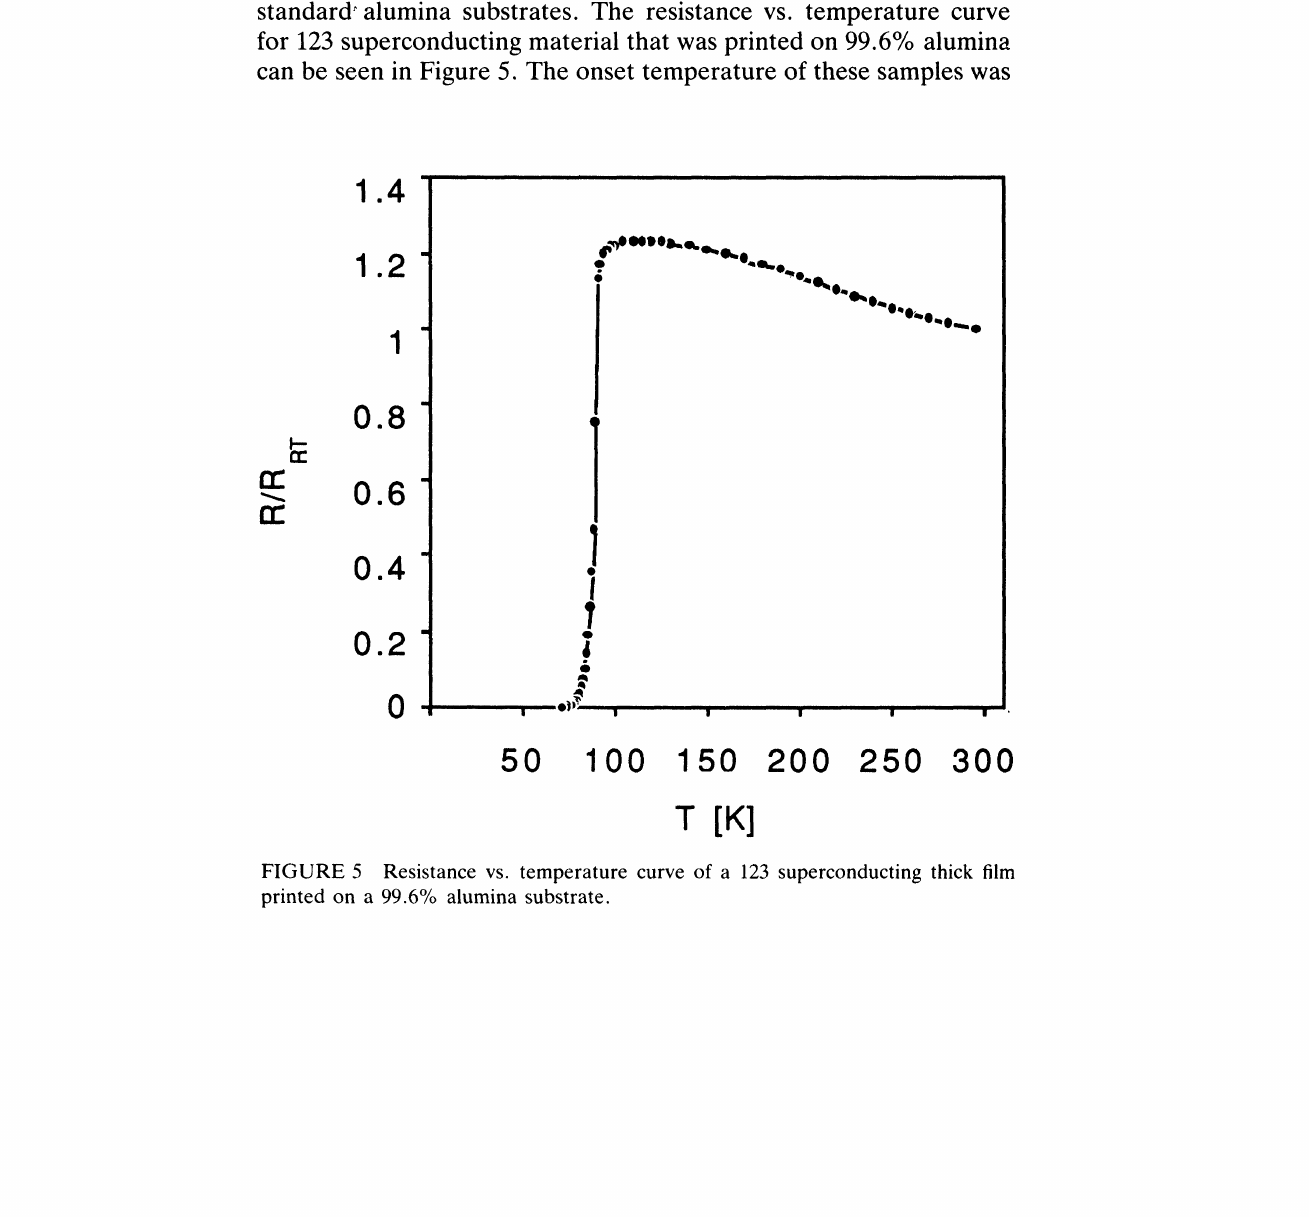
FIGURE 5 Resistance vs. temperature curve of a 123 superconducting thick film printed on a 99.6% alumina